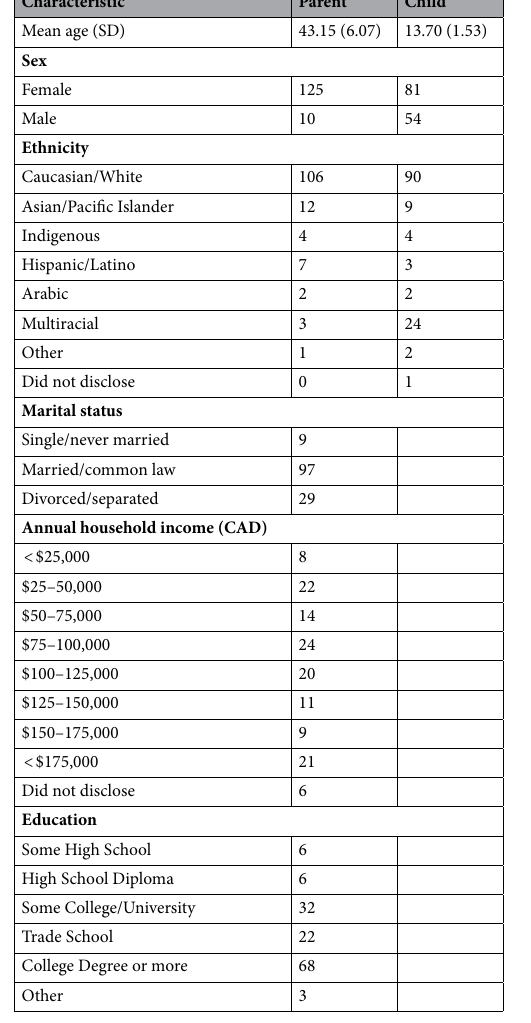
Table 1. Sociodemographic characteristics. SD standard deviation, CAD Canadian